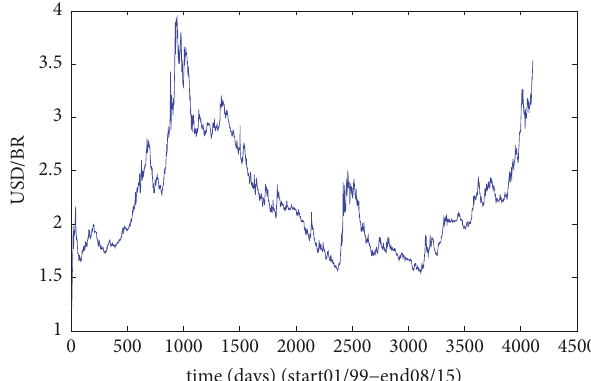
Figure 5: USA Dollar-Brazilian real exchanging rate.